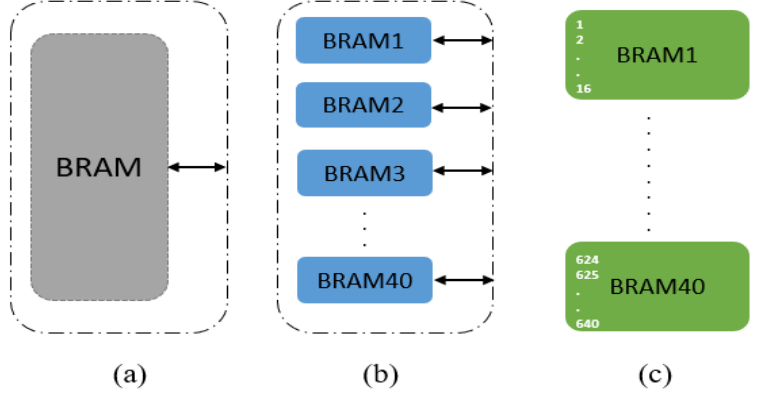
Figure 5. Array partitioning: ( a ) without partitioning; ( b ) block partitioning; and ( c ) block with size=16.